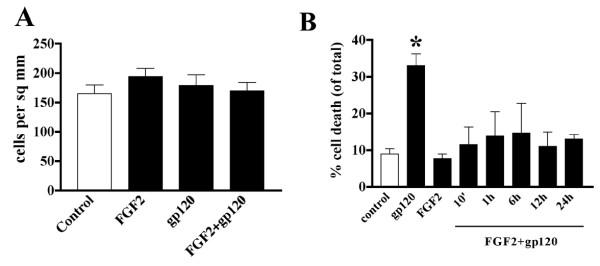
Effects of FGF2 and gp120 on cell proliferation and viability A) Density of proliferating HUVEC exposed to FGF2 and/or gp120. B) Cell viability of cells exposed to gp120 after pre-treating HUVEC with FGF2 for different lengths of time. Cell viability was measured 24 h after gp120 addition. * = P < 0.05 by One-Way ANOVA with post-hoc Dunnett's when compared to control.